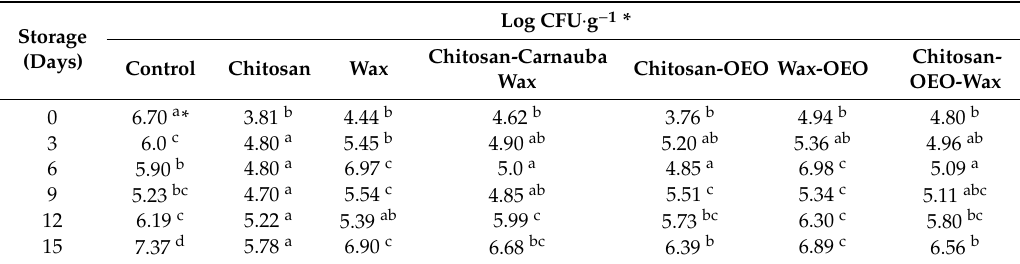
Table 4. Antibacterial activity of chitosan, OEO, and carnauba wax coatings on the mesophilic bacteria load of cucumbers stored at 10 ◦ C for 15